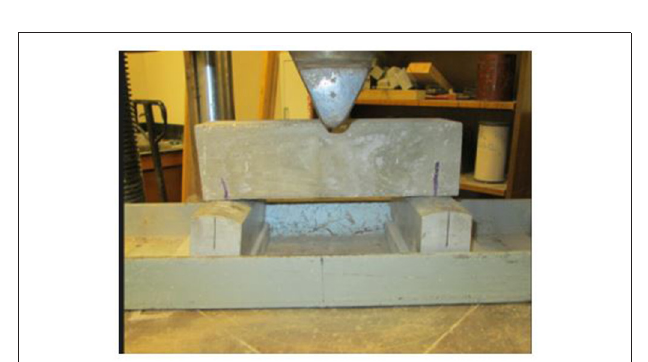
FIGURE 8 | Unlined (control) beam prior to flexural testing.